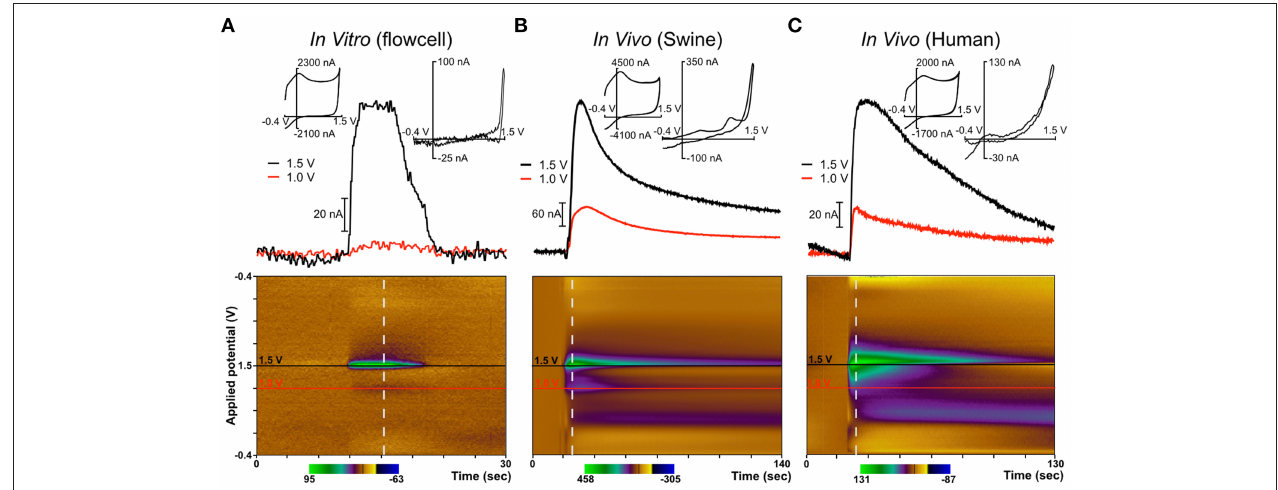
FIGURE 4 | Diamond electrode performance in vitro and in vivo . Panel (A) depicts a diamond electrode’s response to identical in vitro conditions. Panel (B) depicts the same diamond electrode in the ventral lateral thalamus of an anesthetized pig, where an adenosine-like signature secondary to mechanical stimulation was observed. Panel (C) depicts the same electrode in the subthalamic nucleus of an awake human undergoing DBS lead-placement surgery for essential tremor (prior to the DBS lead placement). In panels (B,C) , the signature is consistent with adenosine based on the oxidation peaks near the switching potential at 1.5V. All “diamond” data was recorded with the same specific electrode (although not in the order shown—the human data were always gathered first).